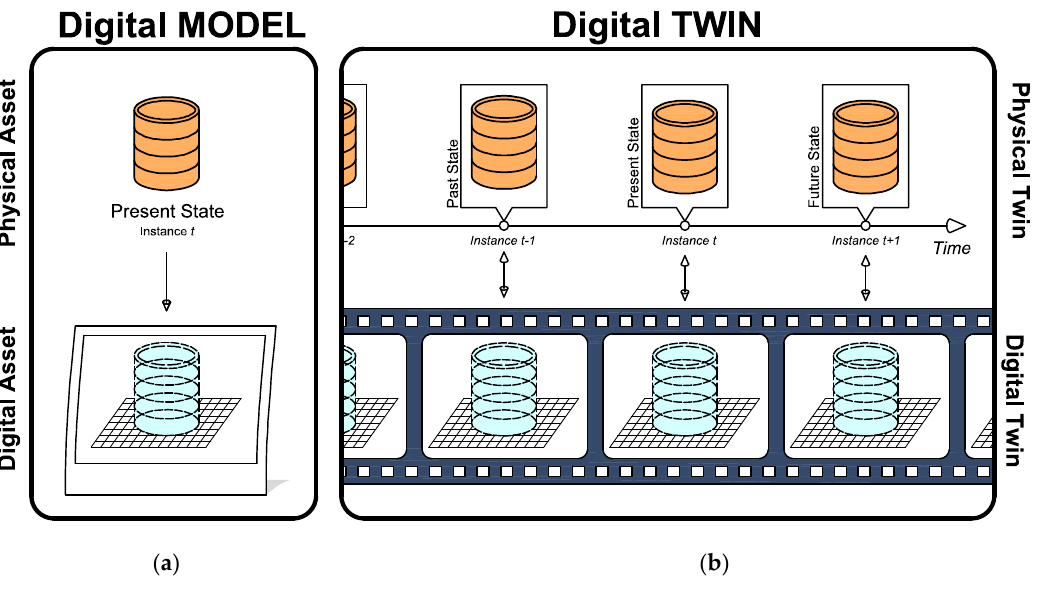
Figure 3. The output of ( a ) a digital model (CAD or BIM) analogous to a “picture” of the asset at the instance it was modeled and ( b ) a Digital Twin analogous to a “set of pictures” or “video” of the evolution of the asset over